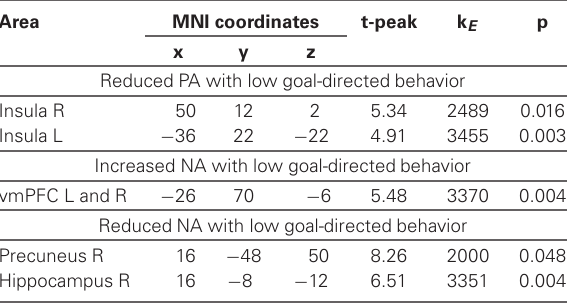
Table 1 | Cluster associated with boredom construct . Area MNI coordinates